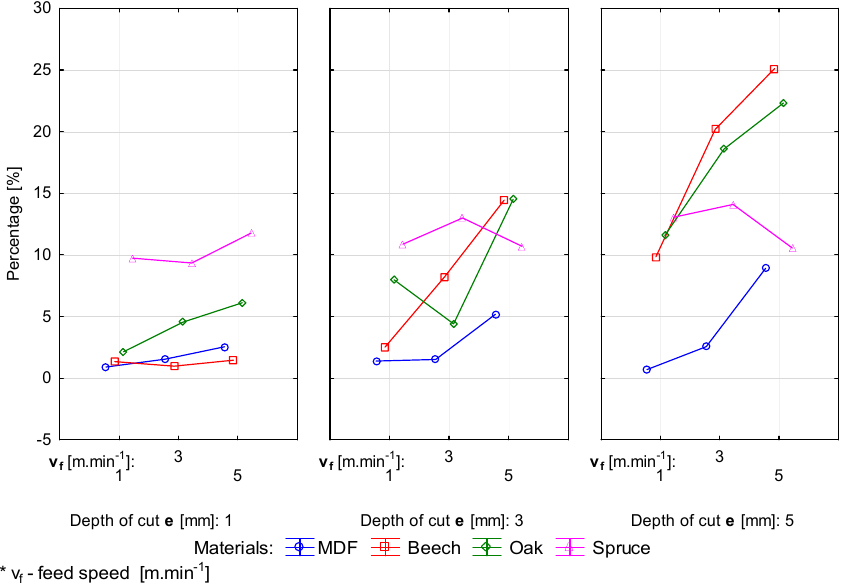
Figure 5. Grain size grade 250 μ m.